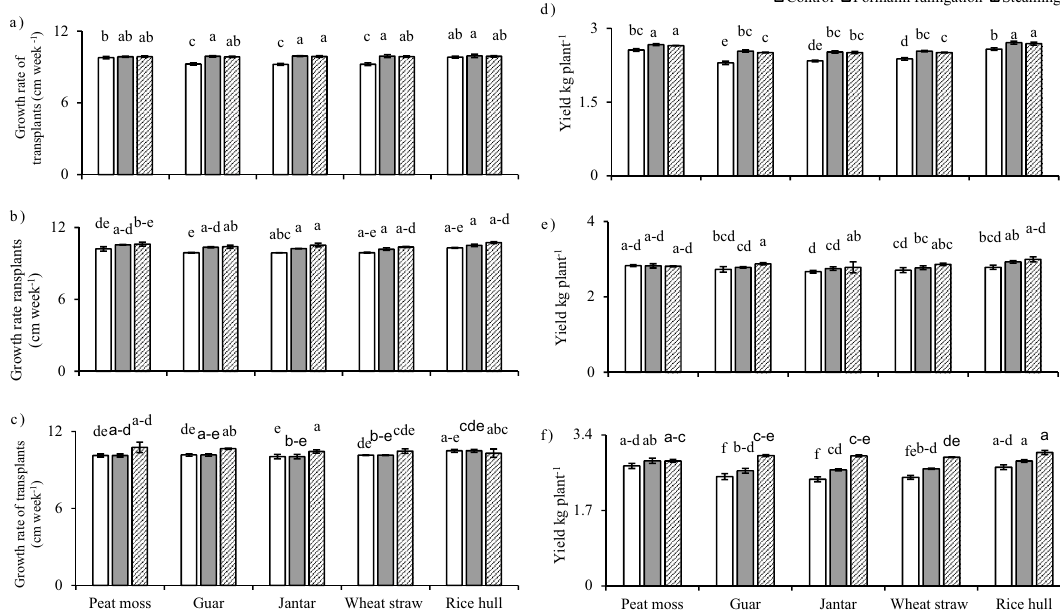
Figure 1. Effect of composts and sanitation techniques on: ( a ) growth rate (cm week −1 ) for site 1; ( b ) growth rate (cm week −1 ) for site 2; ( c ) Growth rate (cm week −1 ) for site 3; ( d ) yield (kg plant −1 ) for site 1; ( e ) yield (kg plant −1 ) for site 2, ( f ) yield (kg plant −1 ) for site 3 of muskmelon. All the values are means ± S.E of three replicates, whereas case letters indicate significant differences among the treatments at p ≤ 0.05 level.